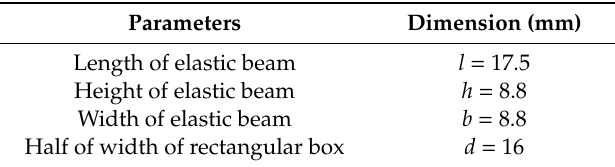
Table 4. Optimal dimensions of the